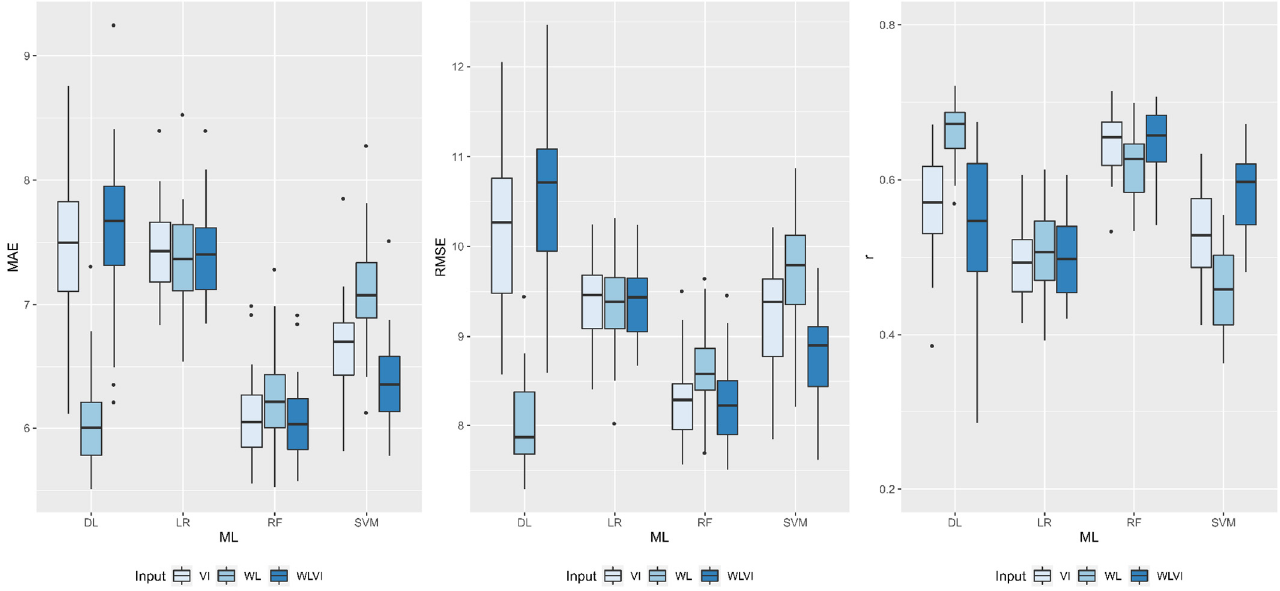
Figure 3. Boxplot for mean absolute error (MAE), root mean squared error (RMSE), and Pearson’s correlation coefficient (r) between estimated and observed values for days to maturity in soybean obtained with different machine learning models (DL, RF, SVM, and LR) and input configurations. DL: deep learning (DL); RF: random forests; SVM: support vector machine; LR: linear regression; WL: spectral bands wavelengths; VI: spectral vegetation indices; WLVI: a combination between spectral bands and vegetation indices.